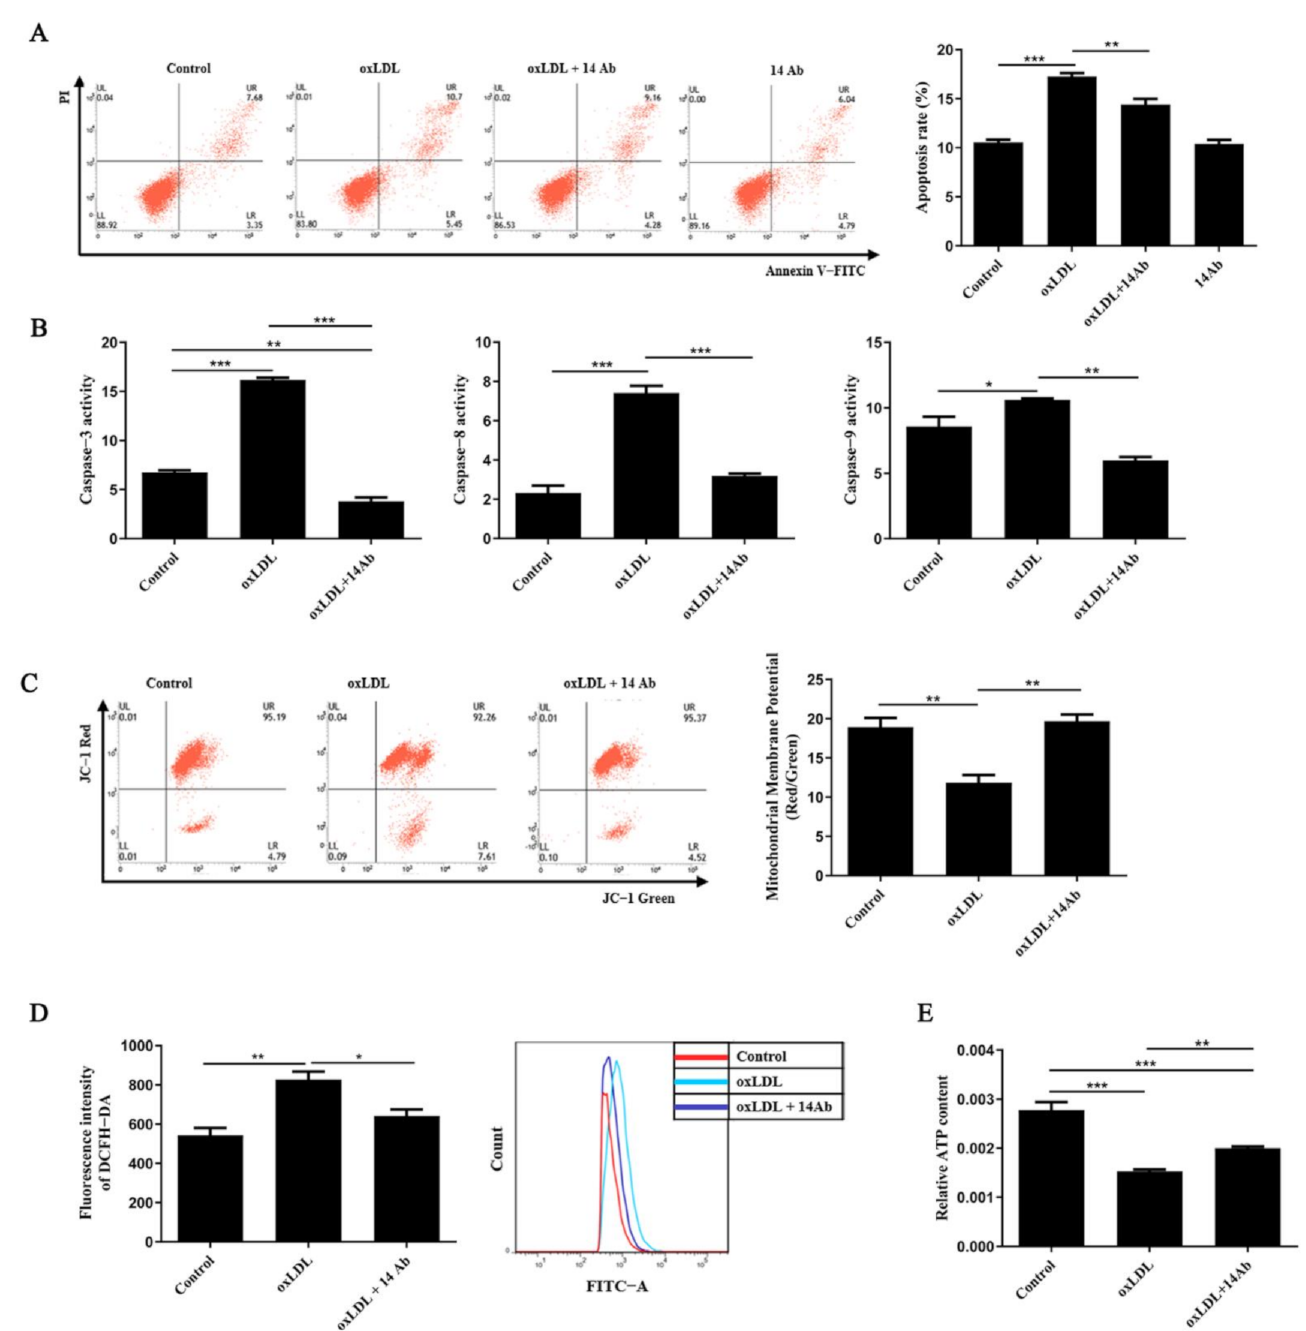
Figure 1. Recombinant humanized IgG1 antibody alleviates oxLDL-induced oxidative stress and apoptosis. THP-1 cells were treated with oxLDL (50 µ g/mL) along with or without the recombinant humanized IgG1 antibody (14 Ab, 100 µ g/mL), or just treated with recombinant humanized IgG1 antibody (14 Ab, 100 µ g/mL) for 8 h, and then the cells were collected to determine apoptosis ( A ), the activity of caspase-3/8/9 ( B ), mitochondrial membrane potential ( C ), ROS production ( D ) and ATP content ( E ), respectively. Data are shown as mean ± SD (n = 4). *, p < 0.05; **, p < 0.01; ***, p < 0.001. oxLDL, oxidized low-density lipoprotein; ROS, reactive oxygen